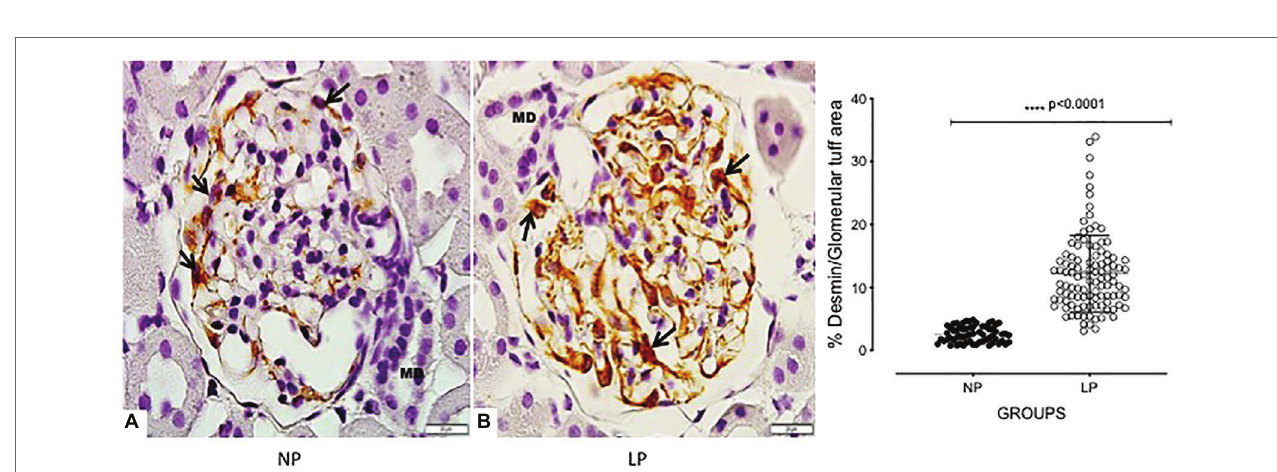
FIGURE 8 | Glomerular tuff desmin immunoperoxidase staining in 24-week-old male NP offspring ( n = 5; A ) compared with age-matched LP progeny ( n = 5; B ). The black arrow indicates podocytes, and the macula densa is shown as MD. A 1000× magnification was used in the glomerular area. The scale bar can be found at the bottom right of each figure. Five cortical and medullar fields of each histological section were analyzed, and the average immunoreactivity reading was determined. Data are presented as scatter dot plots on the right; unpaired Welch’s t -test was used for data analysis. The level of significance was set at p <